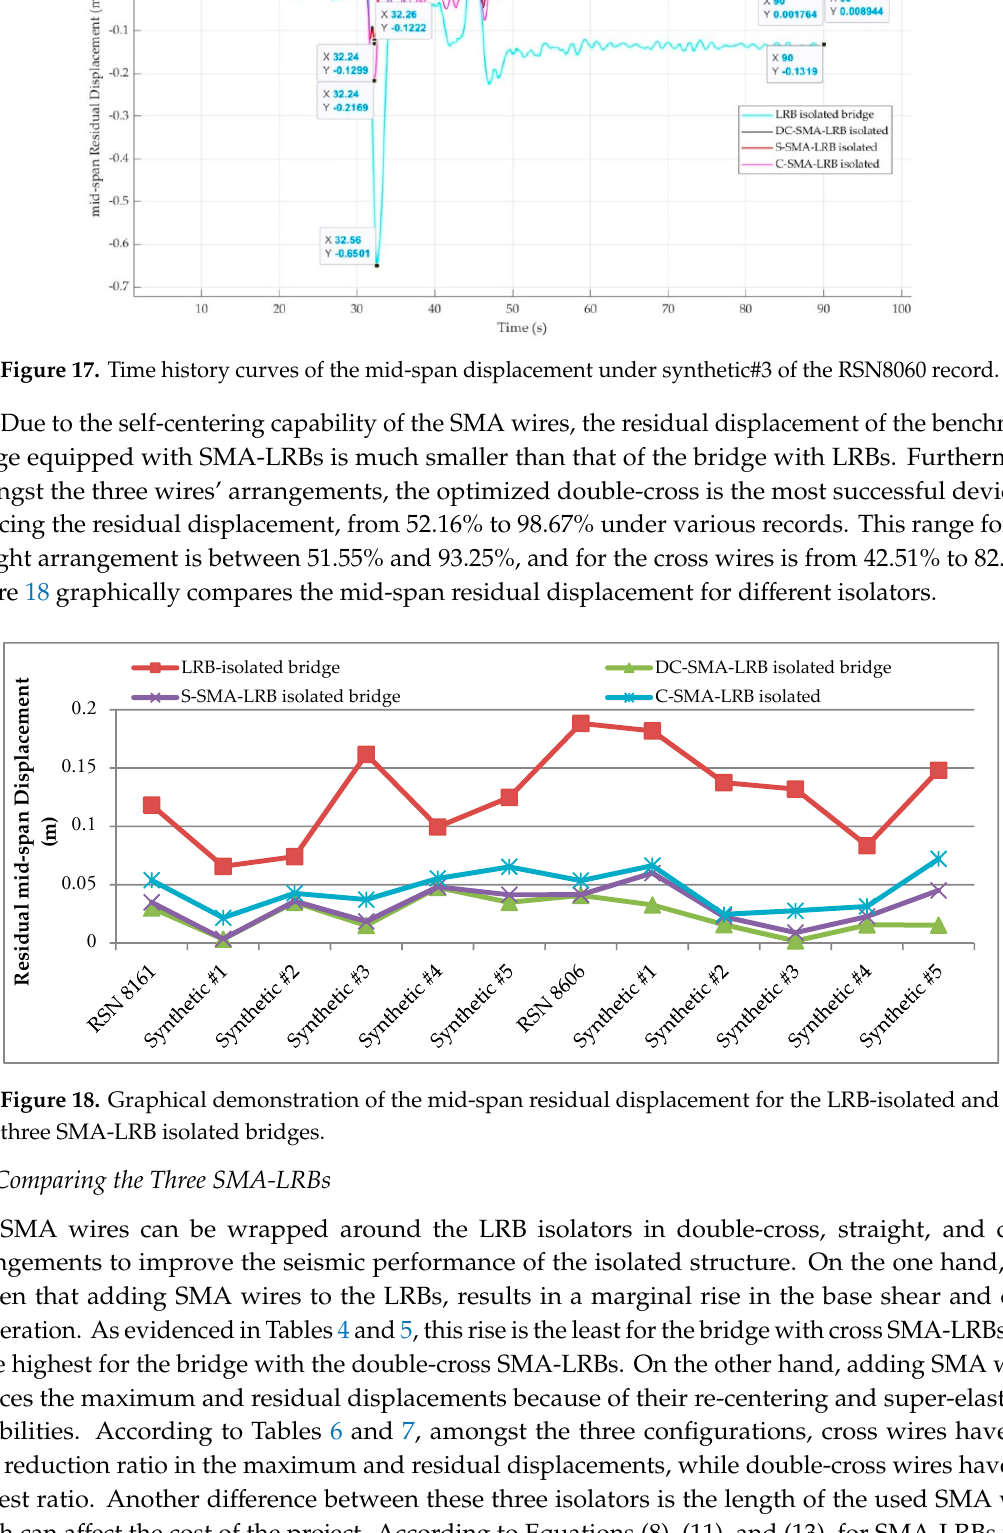
Figure 16. Time history curves of the mid-span displacement under synthetic#3 of the RSN8161 record.